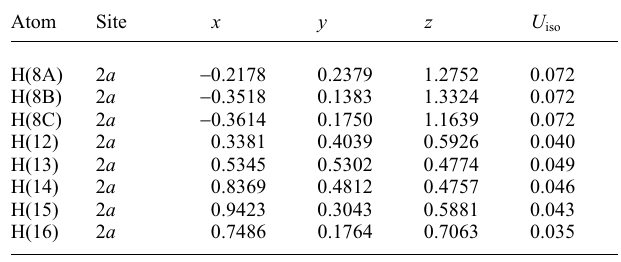
Table 3. Atomic coordinates and displacement parameters (in Å 2 )